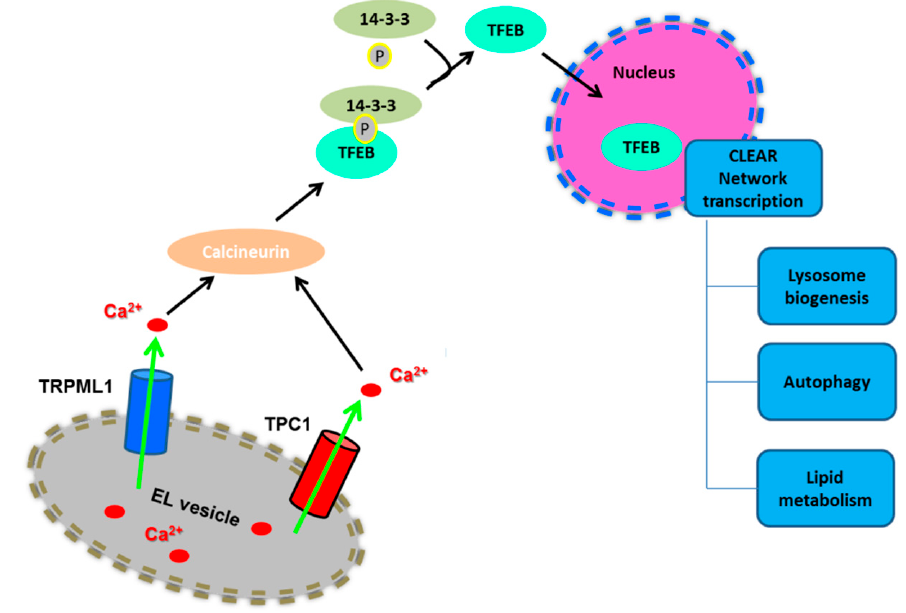
Figure 3. Lysosomal Ca 2+ signaling induces the nuclear translocation of TFEB. Lysosomal Ca 2+ release through TRPML1 or TPC1 stimulates the nuclear translocation of TFEB to activate the CLEAR network transcription. Please, see the text for further details.